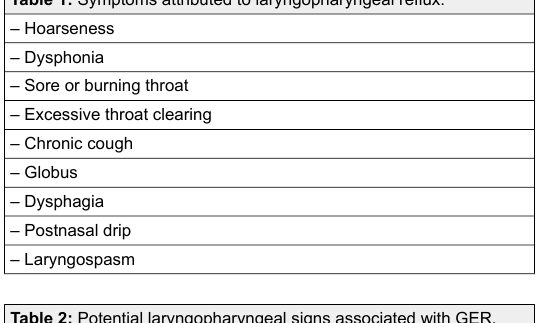
Table 2: Potential laryngopharyngeal signs associated with